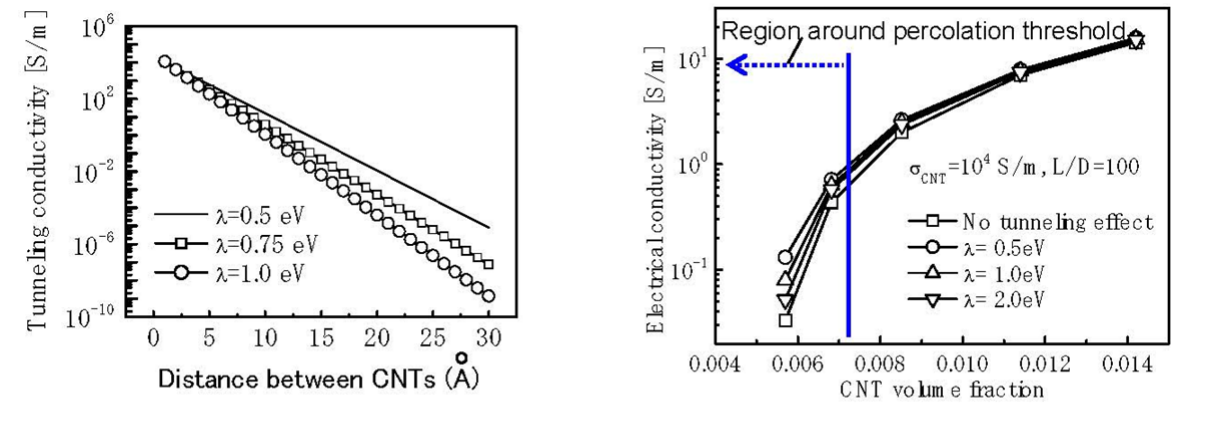
Figure 22. Tunneling conductivity between two CNTs, and tunneling effects on electrical conductivity of